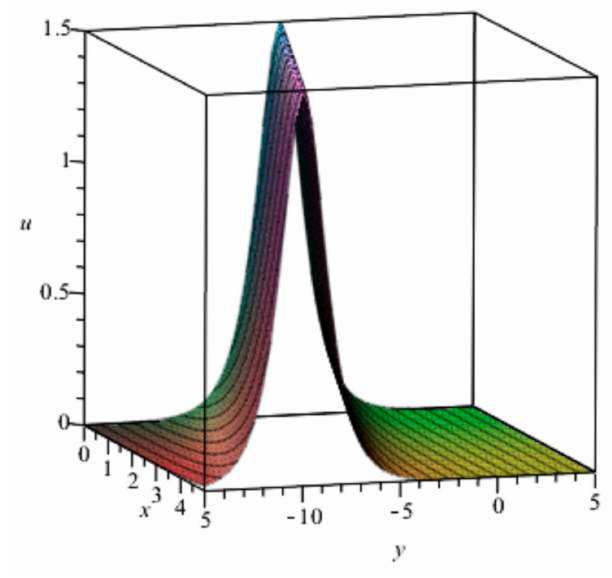
Figure 1. Solution locations for β = 0.05.